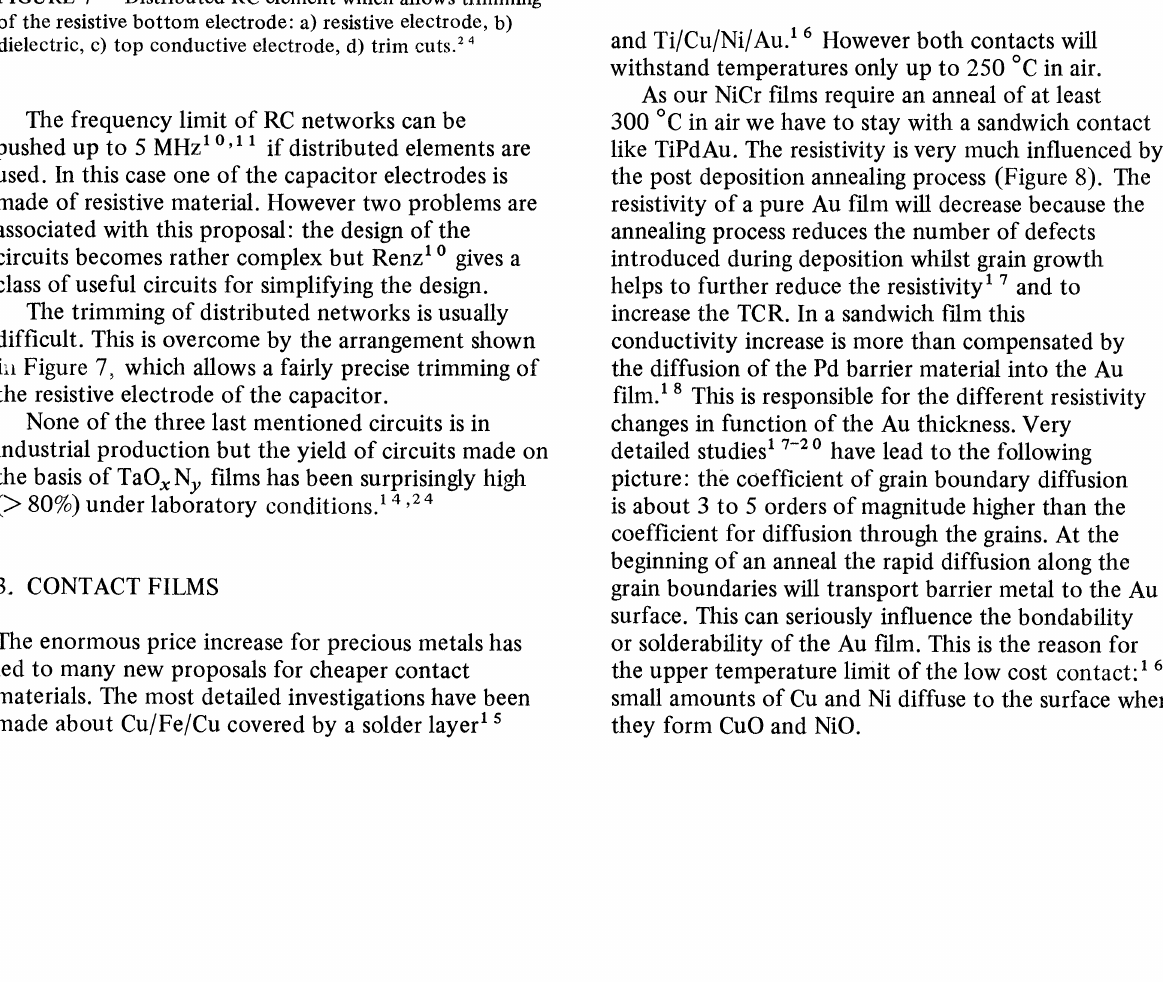
FIGURE 8 Resistivity and TCR of Au and Au (TiPd) contacts on glass as a function of annealing conditions. and Ti/Cu/Ni/Au. 16 However both contacts